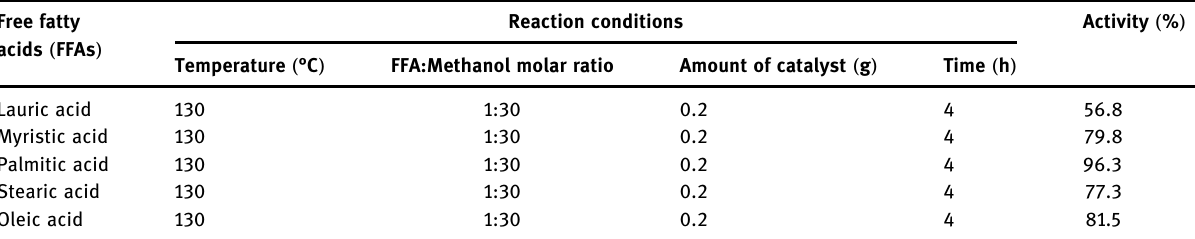
Table 1: Reactivity of di ff erent fatty acids and methanol by Ce - BDC@HSiW@UiO - 66 catalyst Free fatty acids ( FFAs